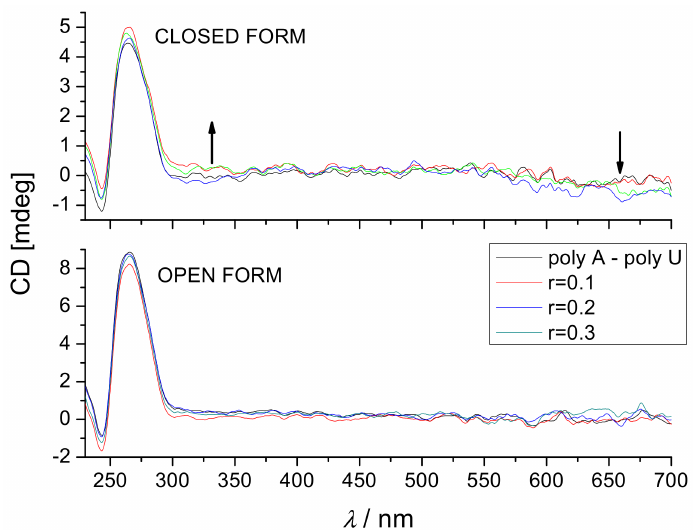
Figure 9. CD titration of poly A—poly U ( c = 2 × 10 − 5 M) with open and closed form of DAE-NH-Py at molar ratios r = [compound]/[RNA]. Done at pH 7.0, buffer sodium cacodylate, I = 0.05 M.